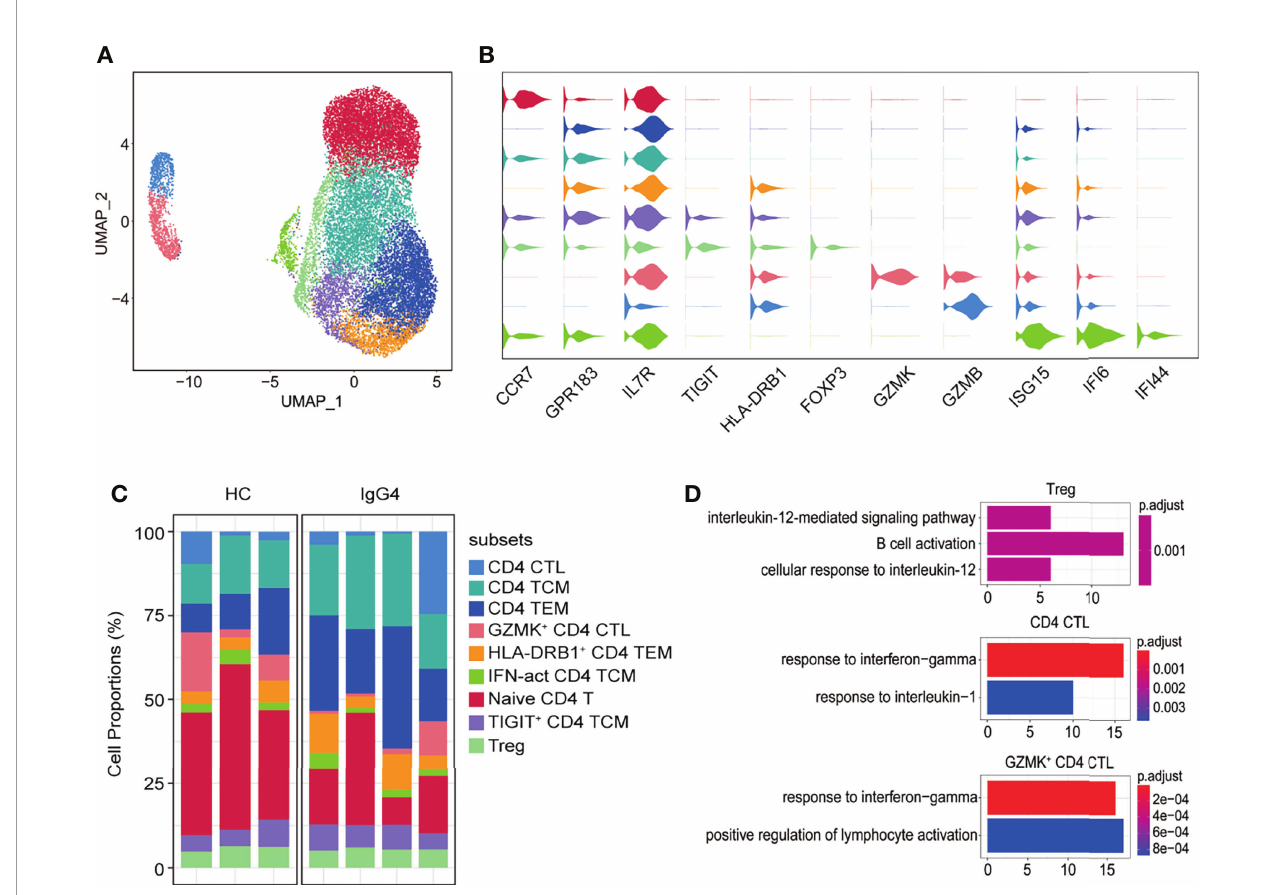
FIGURE 6 | The heterogeneity and transcriptional features of CD4 T-cell subsets in IgG4-RD. (A) UMAP representation of 19,629 CD4 T cells, showing the formation of nine clusters. (B) Violin plots showing expression distribution of canonical cell markers. (C) Bar plot showing cluster abundance of each CD4 T-cell type across all samples. (D) GO analysis showing the biological process enriched in Treg, CD4 CTL, and GZMK + CD4 CTL of patients with